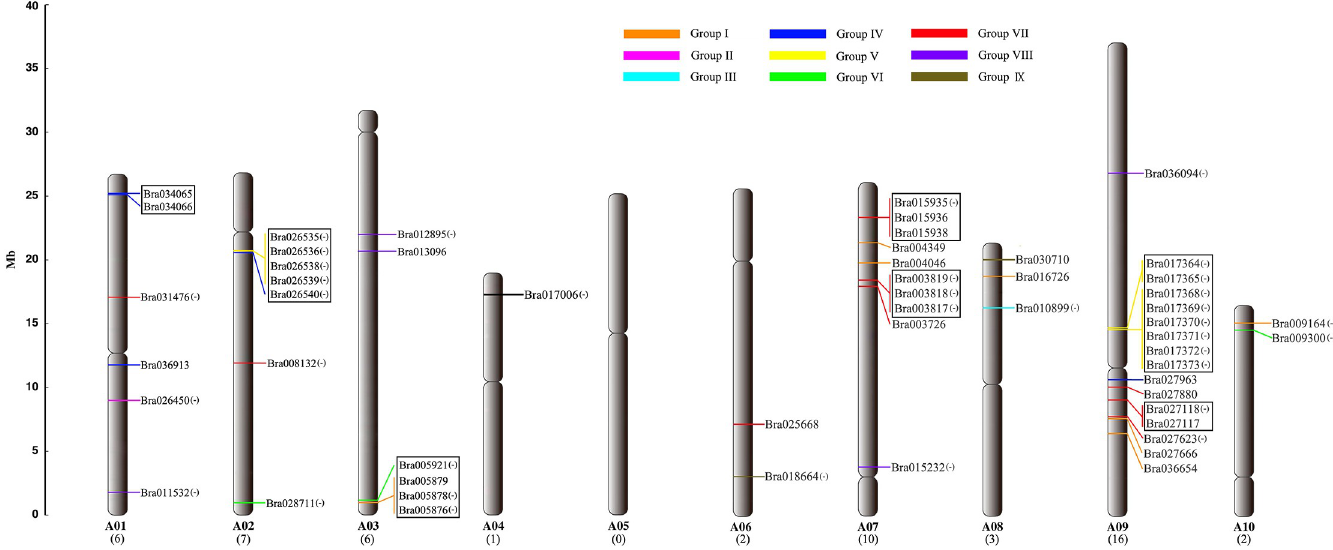
Fig 1. Distribution of 53 sulfotransferase ( SOT ) genes on the 10 Brassica rapa chromosomes. The positions of each gene are based on information in the most recent version of the Brassica database. Three BraSOT genes on the scaffold (Bra034521, Bra041015 and Bra034520) could not be anchored to a specific chromosome. The number under each chromosome code is the number of genes on that chromosome. The group (I–IX) corresponding to each BraSOT gene on a chromosome is indicated by a colored line. Boxes indicate gene